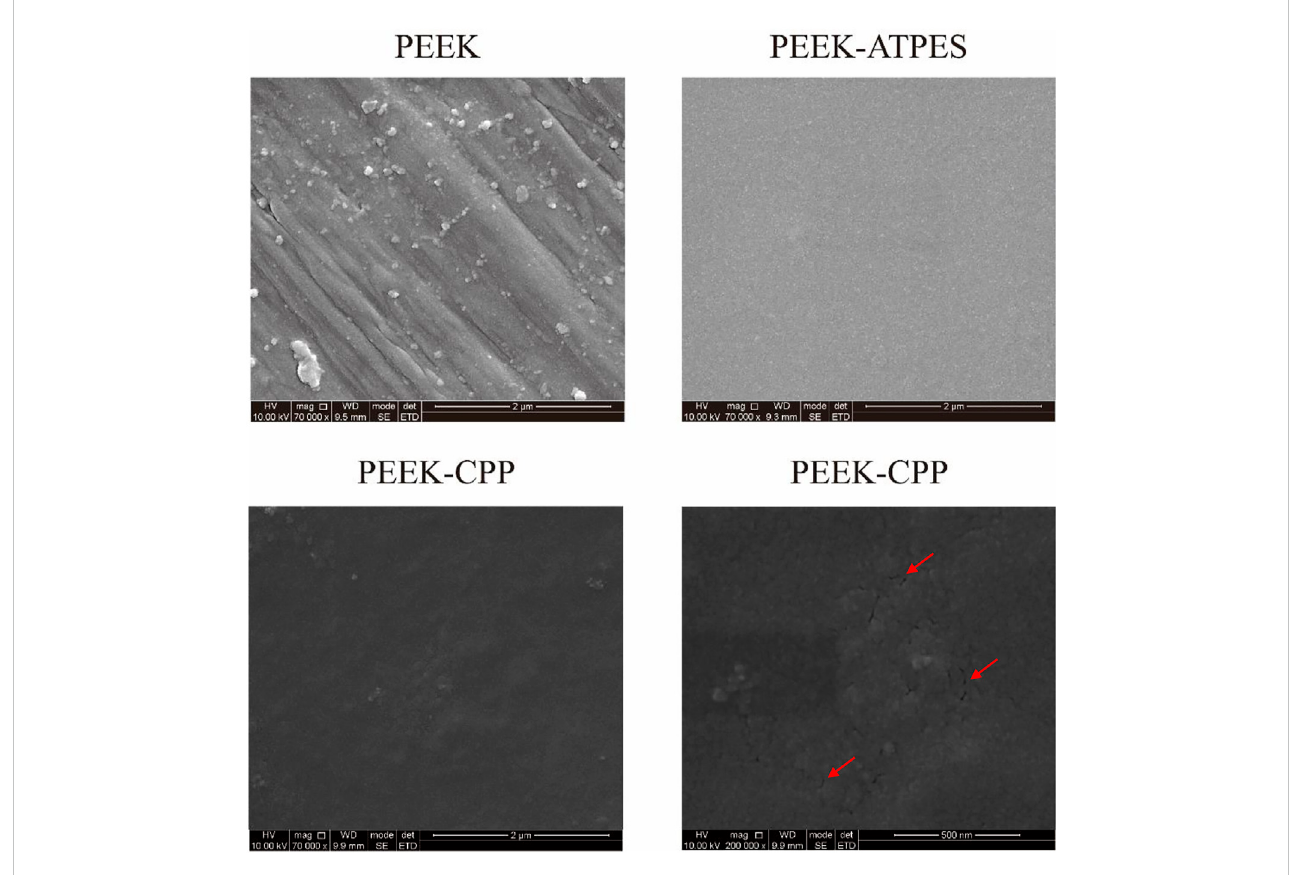
The surface morphology of different PEEK specimens by SEM